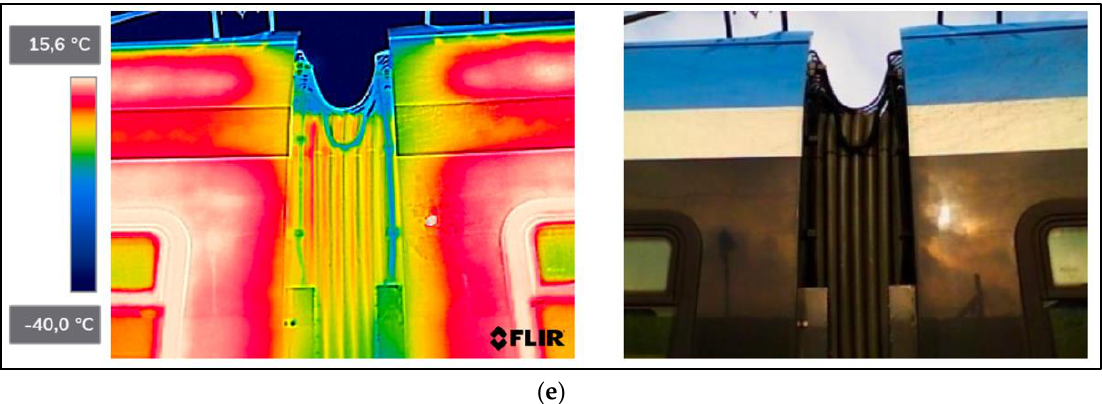
Figure 5. 34WEa-004 − thermogram of critical components of the railway vehicle: ( a ) door − upper part from inside the vehicle; ( b ) door − lower part from inside the vehicle; ( c ) door from outside the vehicle; ( d ) interconnection from inside the vehicle; ( e ) interconnection from outside the vehicle.